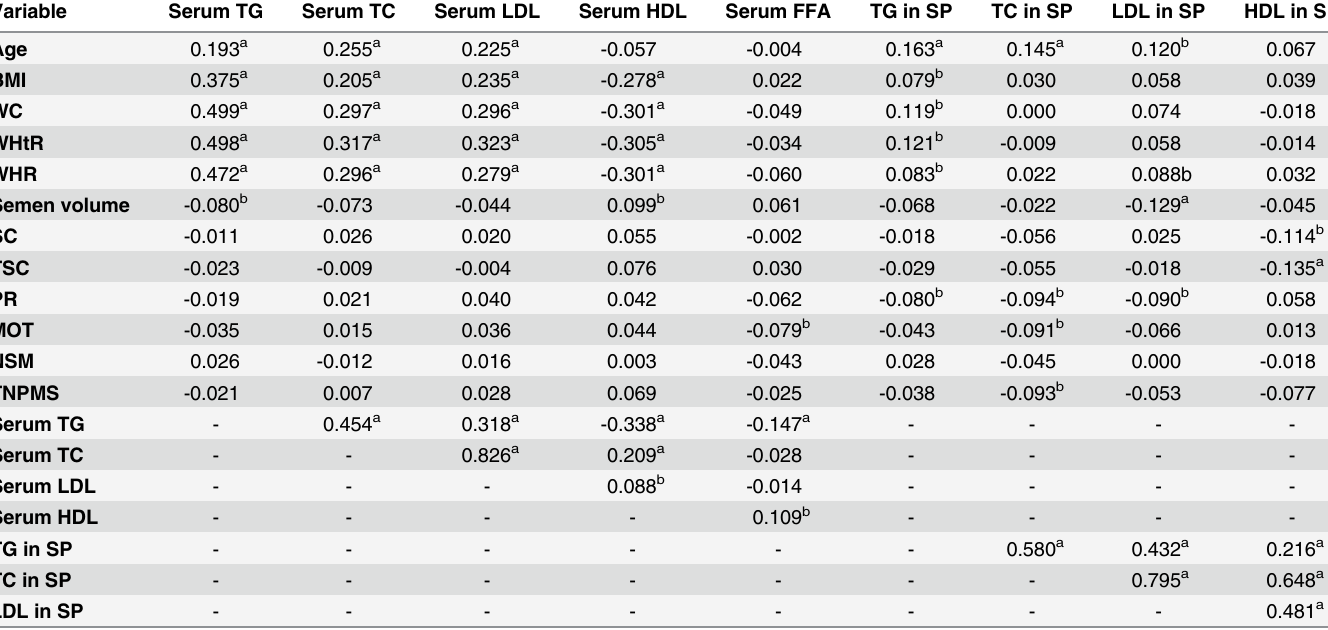
Table 2. Nonparametric (Spearman) correlation coefficients between serum or seminal plasma lipids levels and age, obesity-associated markers and semen parameters.